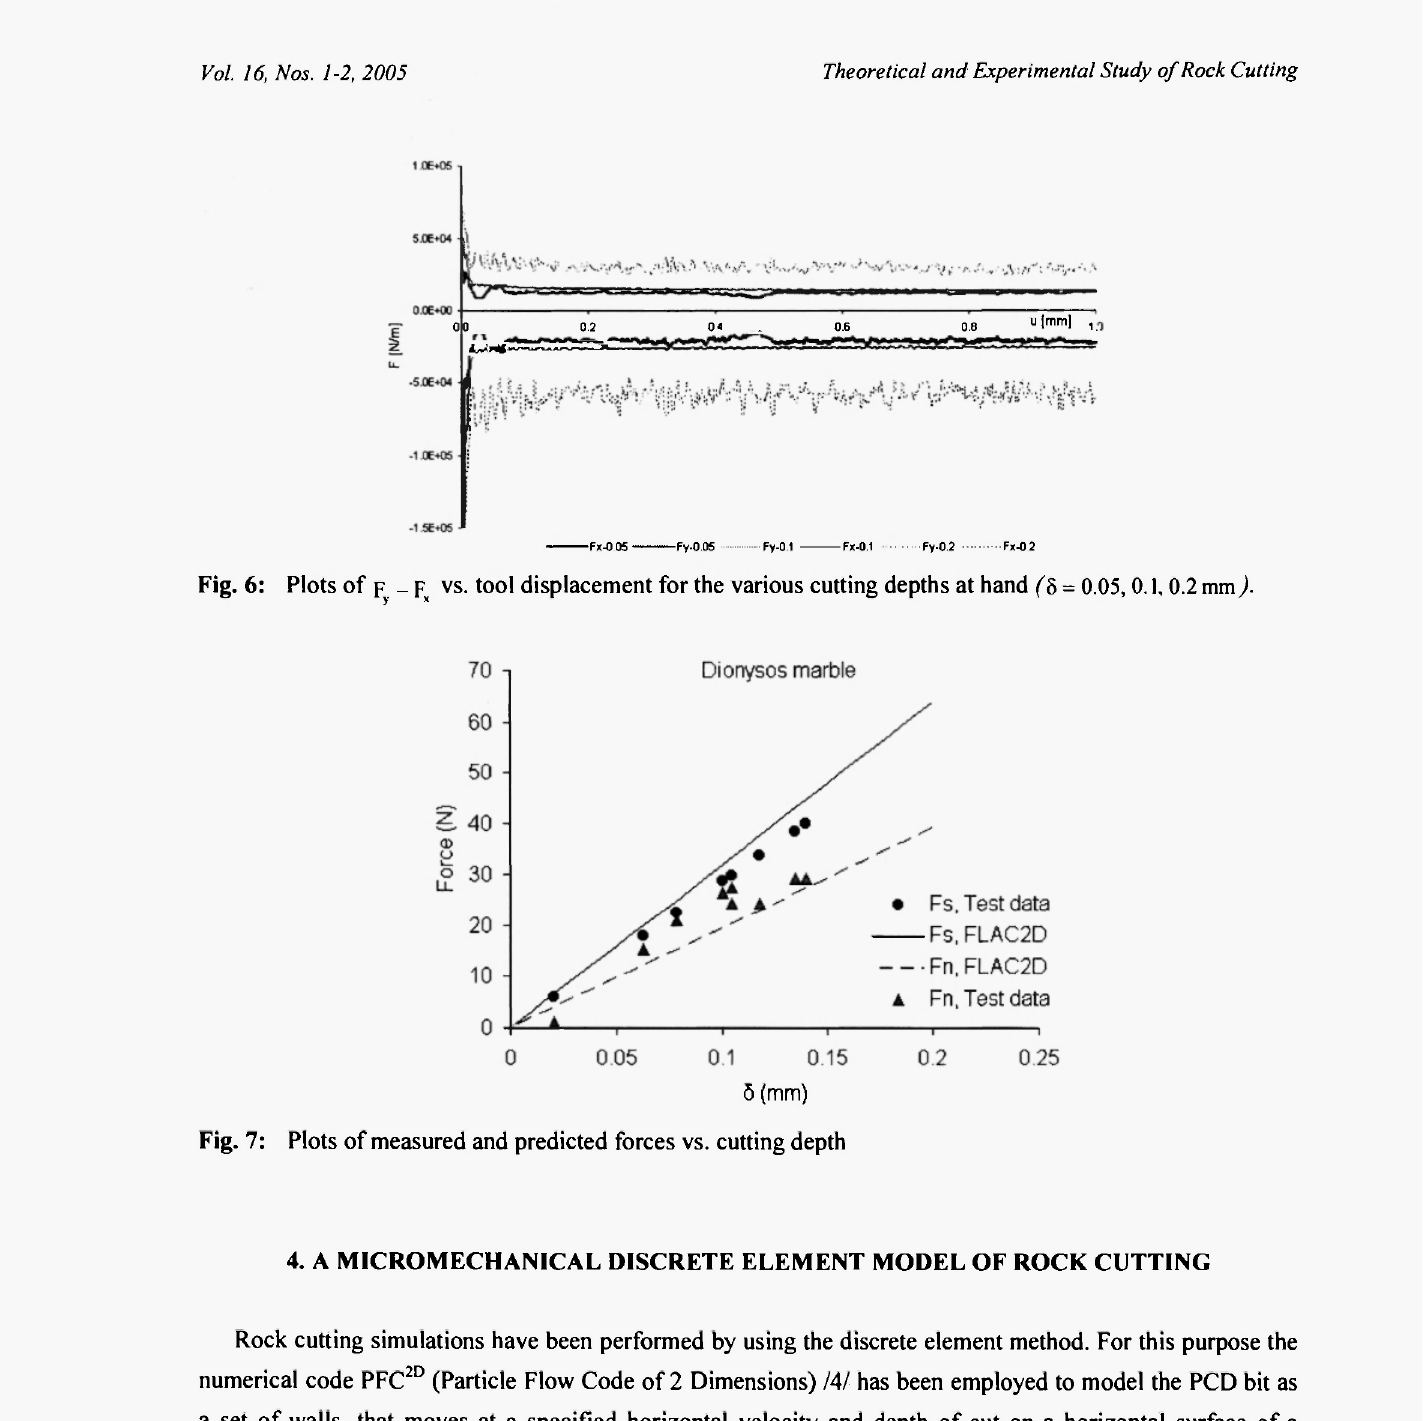
Fig. 7: Plots of measured and predicted forces vs. cutting